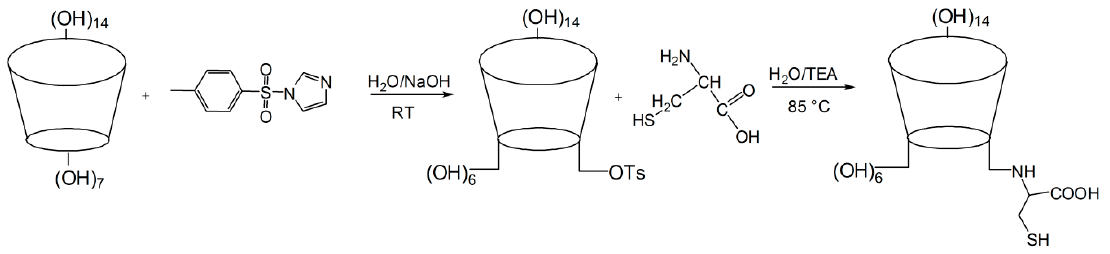
Scheme 1. Schematic illustration of synthesis of cysteinyl β -CD.